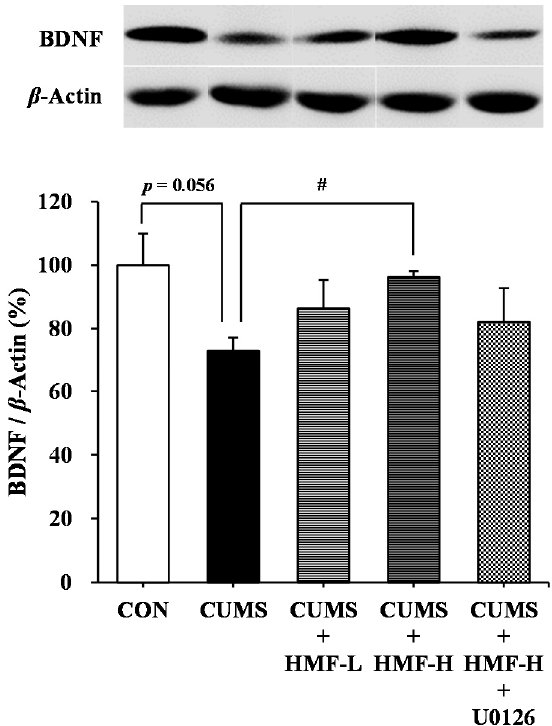
Figure 6. Western blot analysis of brain-derived neurotrophic factor (BDNF) in the CUMS-treated mouse hippocampus on Day 16. Values are means ± SEM ( n = 5). CON vs. CUMS ( p = 0.056 the Student’s t -test), CUMS vs. CUMS + HMF-H ( # p < 0.05, one-way ANOVA followed by the post-hoc Williams multiple comparison test).